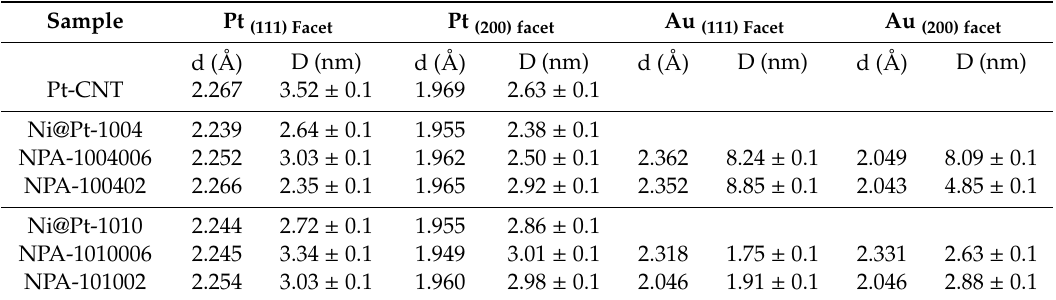
Table 1. Structural parameters of experimental nanocatalysts (NCs) and control samples as determined by XRD and TEM.